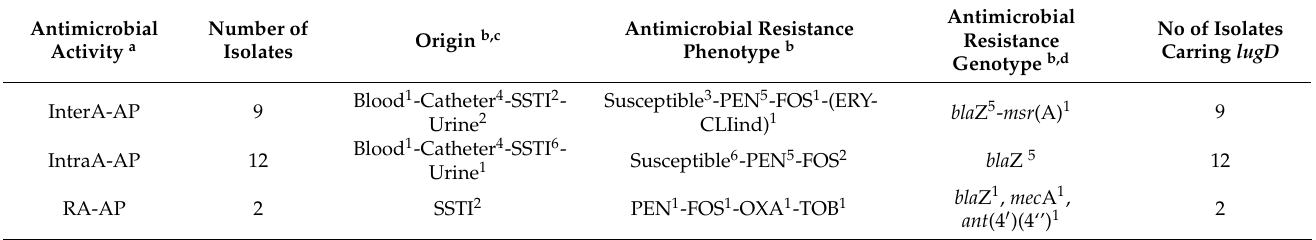
Table 4. Origin, type of sample, antimicrobial resistance phenotype/genotype and bacteriocin genes of the 23 AP isolates based on the antimicrobial activity categories.